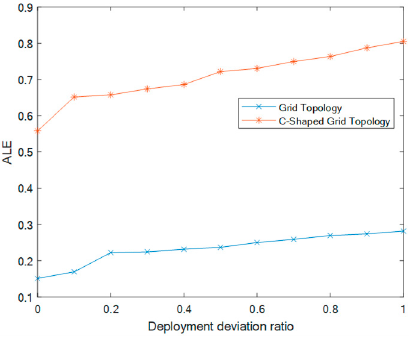
Figure 3. Effect of deployment deviation factors on two grid topology average localization error (ALE).